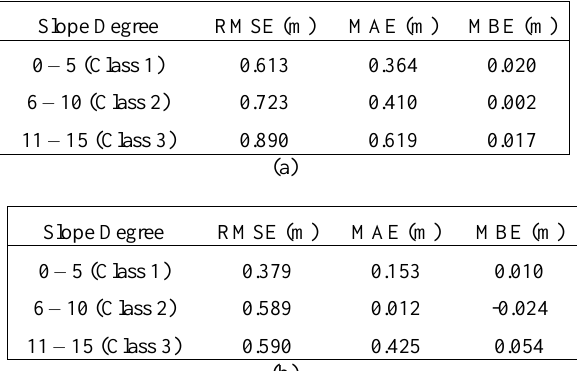
Table 3. Error of LiDAR-derived DTM associated with terrain slope over (a) rubber trees area, and (b) mixed-forest area